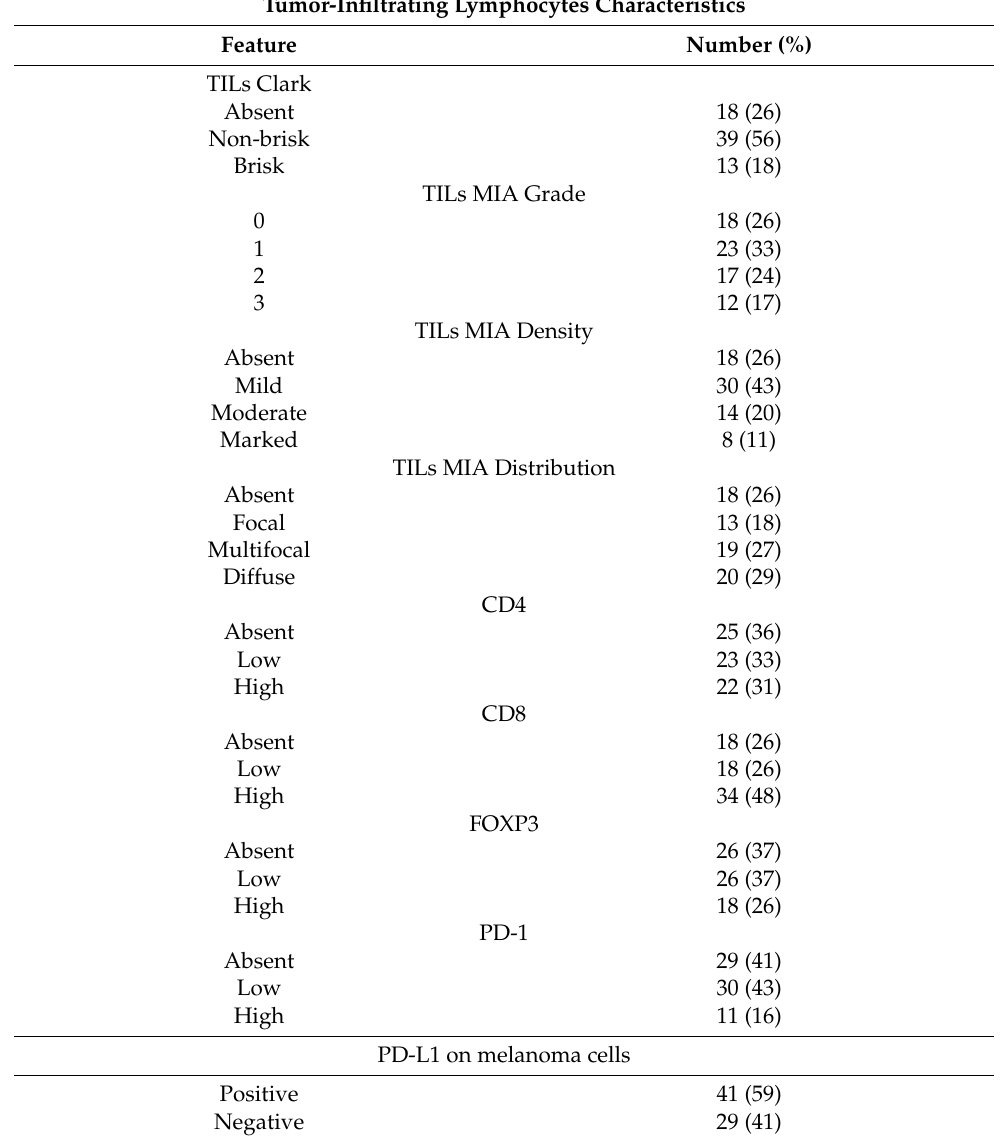
Table 2. Baseline immunohistochemical features of melanoma cases.